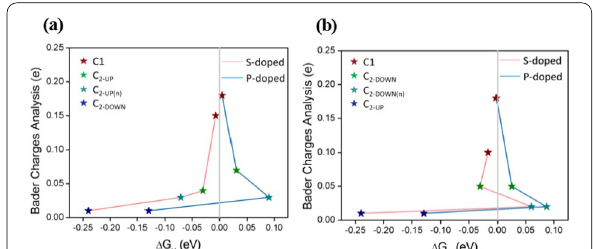
Fig. 7 Relationship between Δ G H and Bader charges analysis for a V